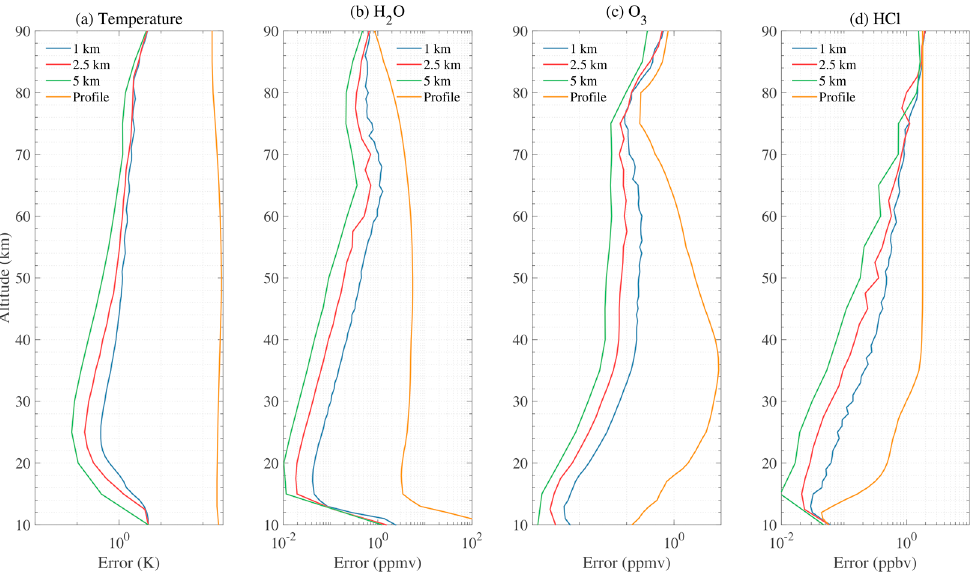
Figure 4. The retrieval precision of the four radiometers with different retrieval grids, and only random noises are added: ( a ) 118 GHz temperature retrieval; ( b ) 190 GHz H2O retrieval; ( c ) 240 GHz O3 retrieval; ( d ) 643 GHz HCl retrieval. The 1 km, 2.5 km, 5 km represent the different retrieval grids. The “Profile” represents the typical profile.